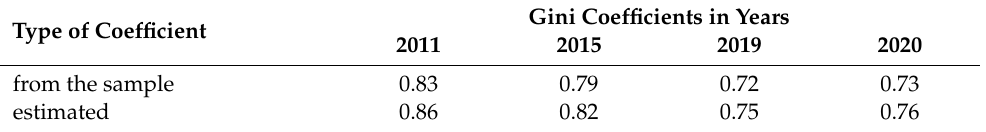
Gini Coefficients in Years